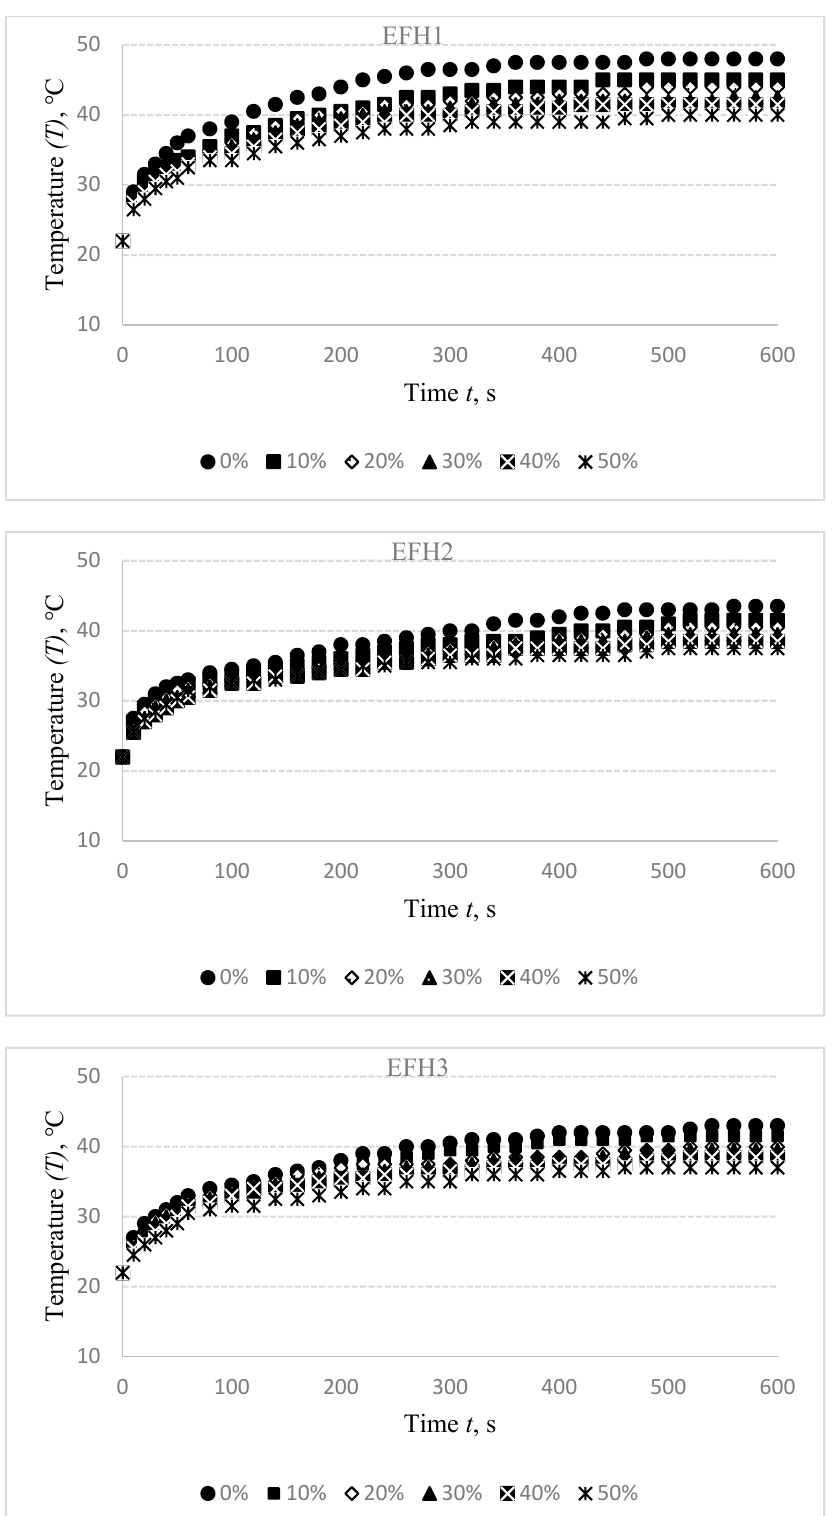
Figure 6. Temperature changes of EFL1, EFL2, EFL3, EFH1, EFH2, and EFH3 structured electro- conductive fabrics during the 600 s period at different stretch levels.